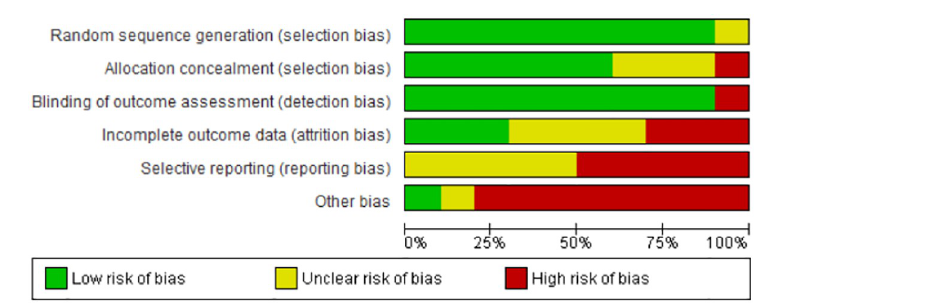
Fig 2. Graph over the risk of bias in the included